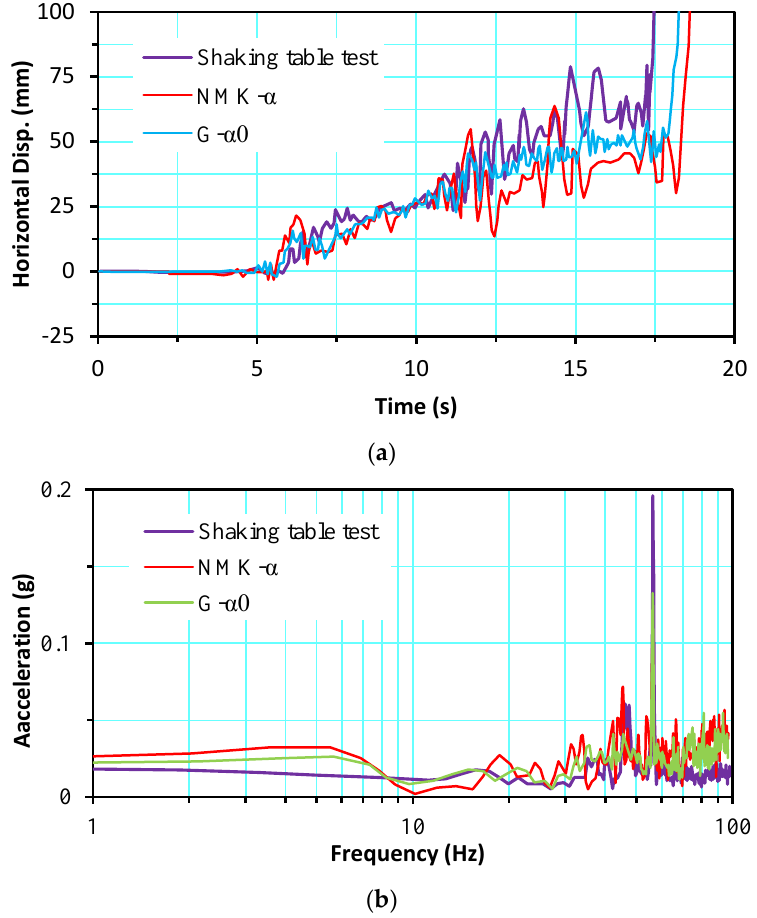
Figure 20. Comparisons of the results between the numerical and the shaking table test. ( a ) Horizontal displacement of the top block. ( b ) Horizontal acceleration spectrum of the top block.